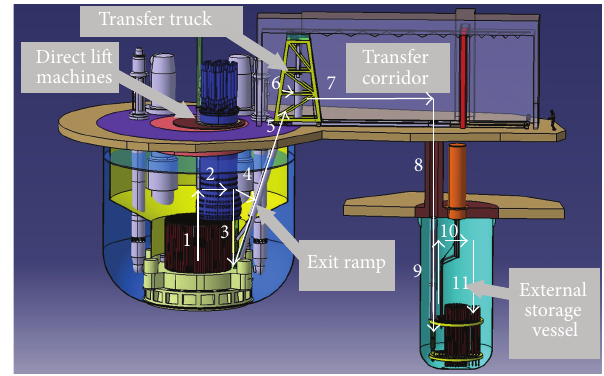
Figure 8: Steps of the three-rotating-plug solution in detail (1: the assembly is extracted from the core using one of the two direct lift machines, 2: the rotating plug movements position the direct lift machine above the horizontal transfer mechanism pot (HTMP), 3: the assembly is lifted down into the HTMP, 4: the HTMP is tilted in the exit ramp, 5: the HTMP is driven back up the ramp to its position in the transfer truck, 6: the HTMP is tipped vertically into the transfer truck, 7: the transfer truck moves along the corridor to its position above the external storage vessel, 8: the HTMP is lifted down vertically into the EVST, 9: the assembly is picked up by a fuel handling arm and removed from the HTMP, 10: the fuel handling arm positions the assembly above its storage location, and 11: the fuel handling arm sets the assembly down in its location).